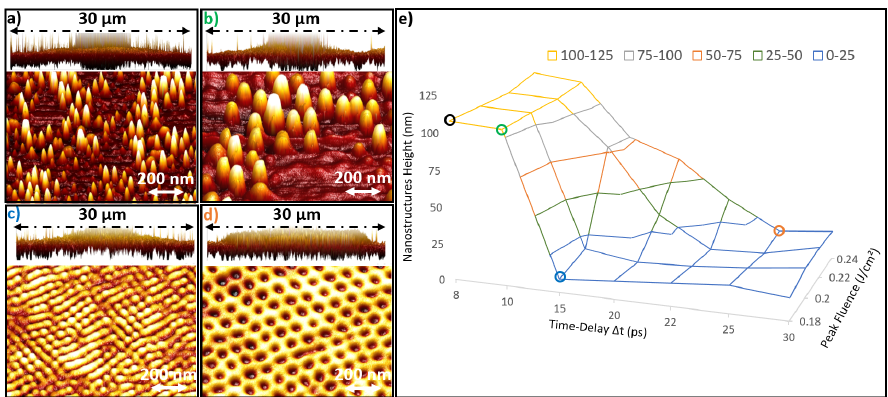
Figure 2. ( a – d ) The 3D AFM images of the laser spot topography in the spallation regime and the principal nanostructures types (nanopeaks, nanobumps, nanohumps and nanocavities). ( e ) Maximum nanostructures height as a function of time delay and laser fluence. The colored circles in ( e ) (black, green, blue and orange) present respectively the regions of ( a – d ) nanostructures.